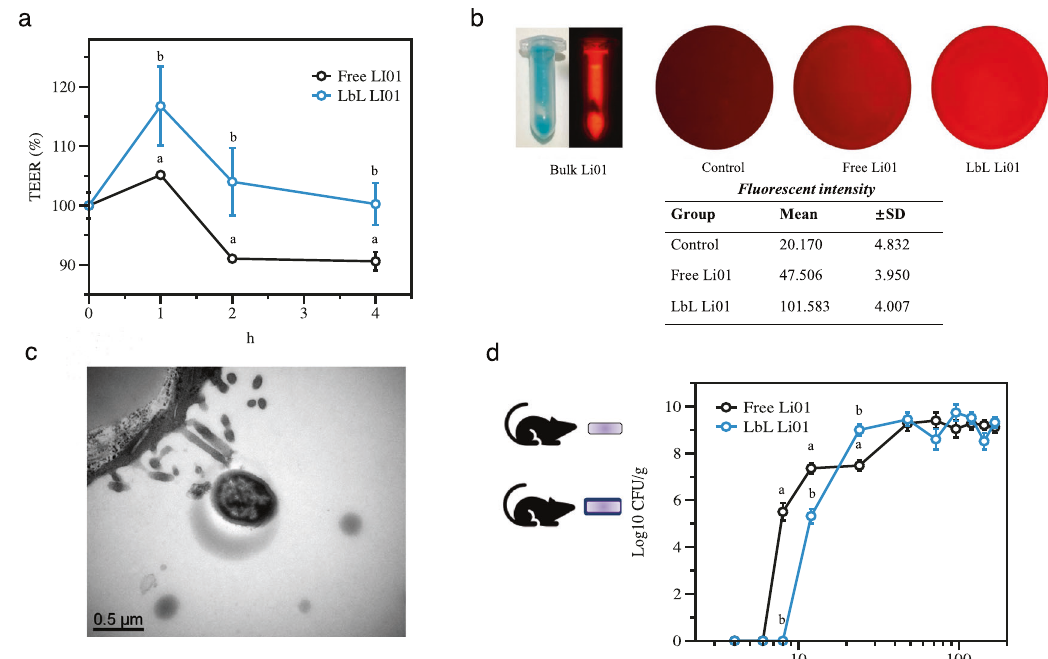
Fig. 3 Adhesion of free Li01 and LbL Li01 on a Caco-2 cell monolayer model. The effect of probiotics on transepithelial electrical resistance (TEER) is shown in ( a ). Li01 adhesion on the cell monolayer was visualized by an in vivo imaging system (IVIS) and the fl uorescence intensity was quanti fi ed. Fluorescence intensities are presented as means from triplicates ± standard deviation (SD) ( b ). Li01 cell attachment to the monolayer was visualized by TEM imaging ( c ). The concentrations of probiotics were monitored in the feces of germ-free rats during one week after oral administration of free Li01 or LbL Li01 ( d ). Data are presented by mean ± SD, n = 5, different letters indicate signi fi cant differences between groups ( P